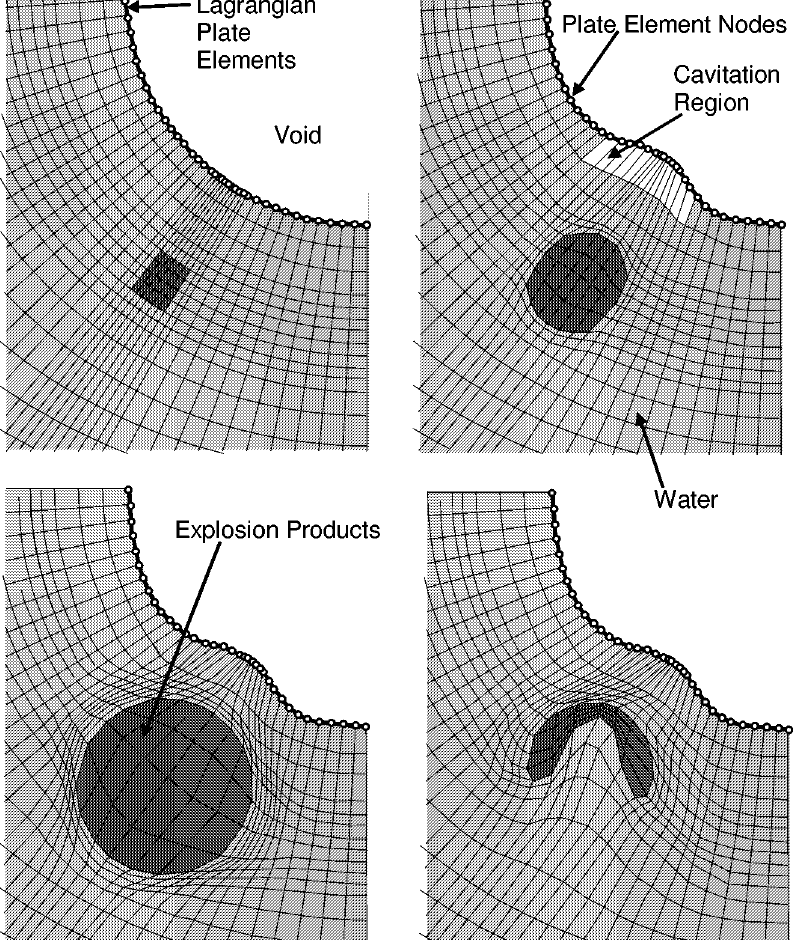
Fig. 8. Single material ALE hydrocode UNDEX-SMI